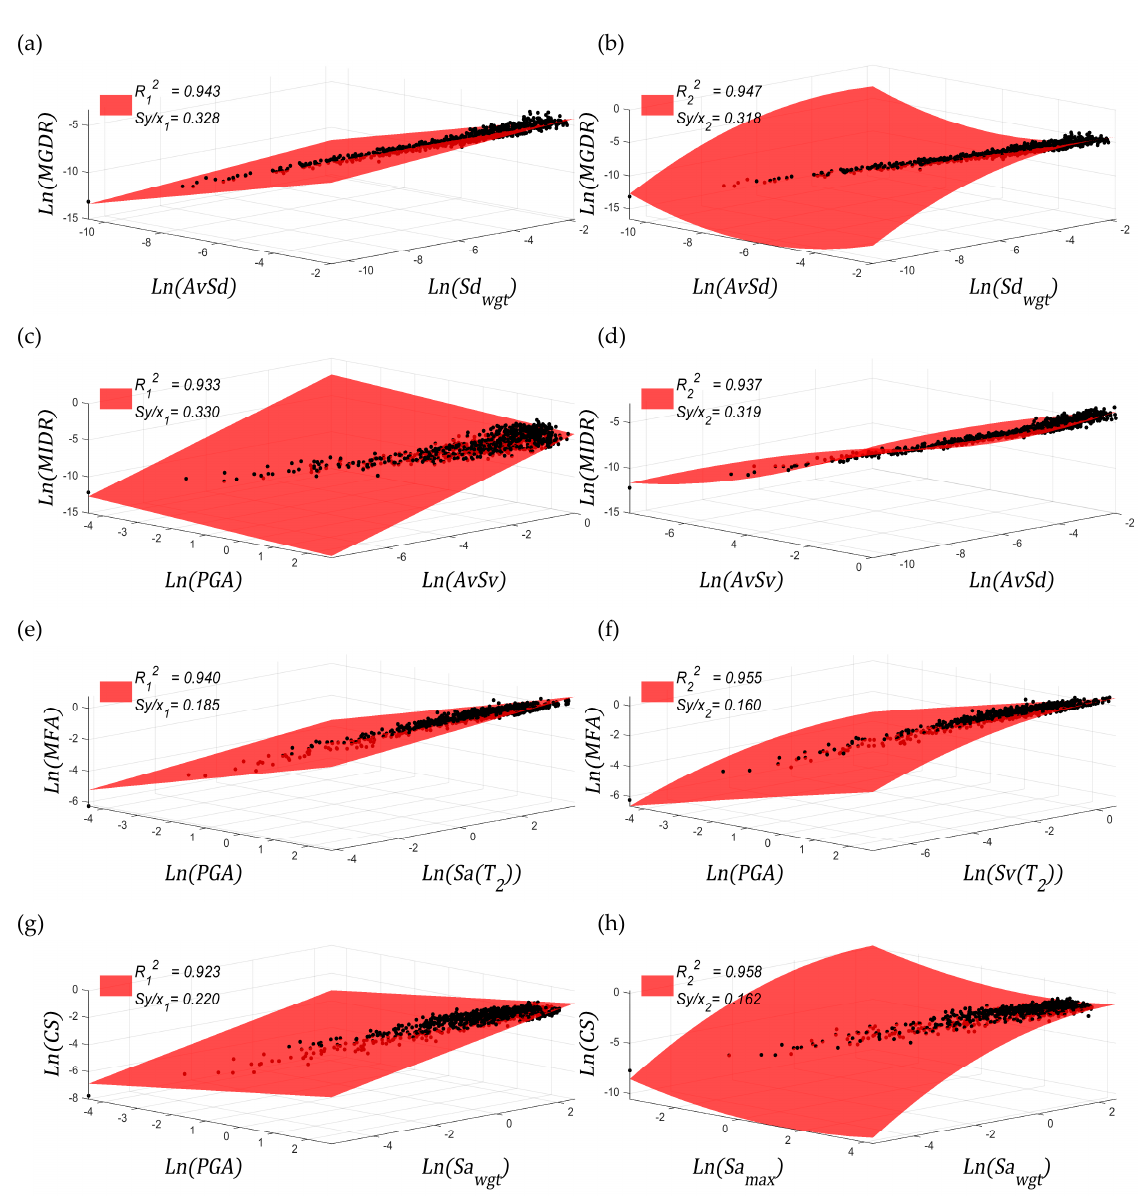
ones. A seven-story reinforced concrete building has been used as a testbed. The structural analysis employed to perform the calculations has been the NLDA.